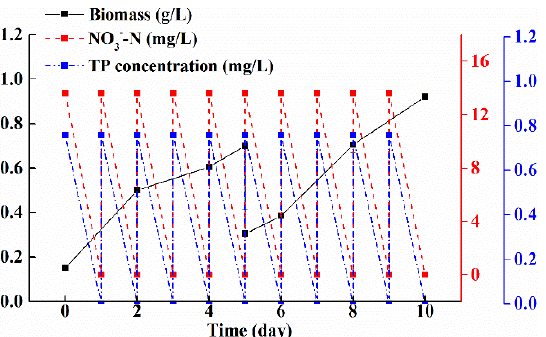
Figure 8. Growth curve of Arthrospira platensis cultivated in a circular photobioreactor and changes in residual NO 3 − -N and total inorganic phosphorus concentration.